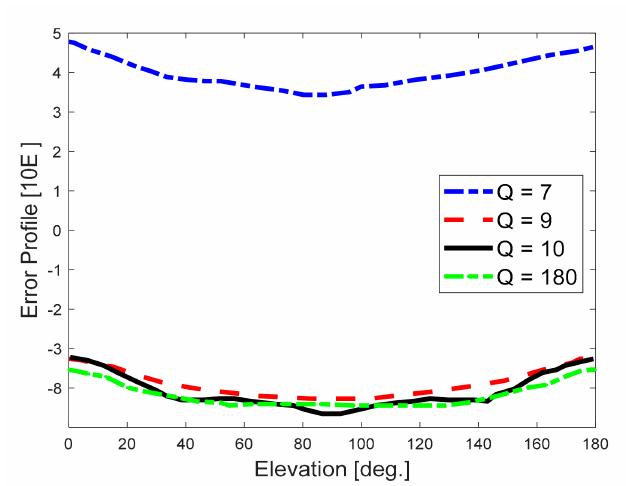
Figure 2. Error profile based on the elevation